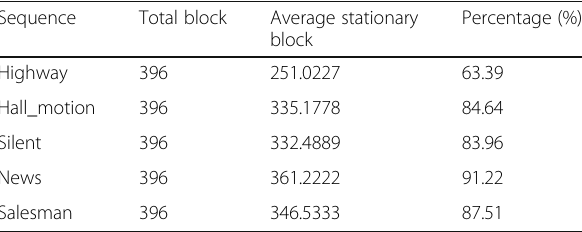
Table 7 The total block, average stationary block, and percentage parameters of the five QCIF